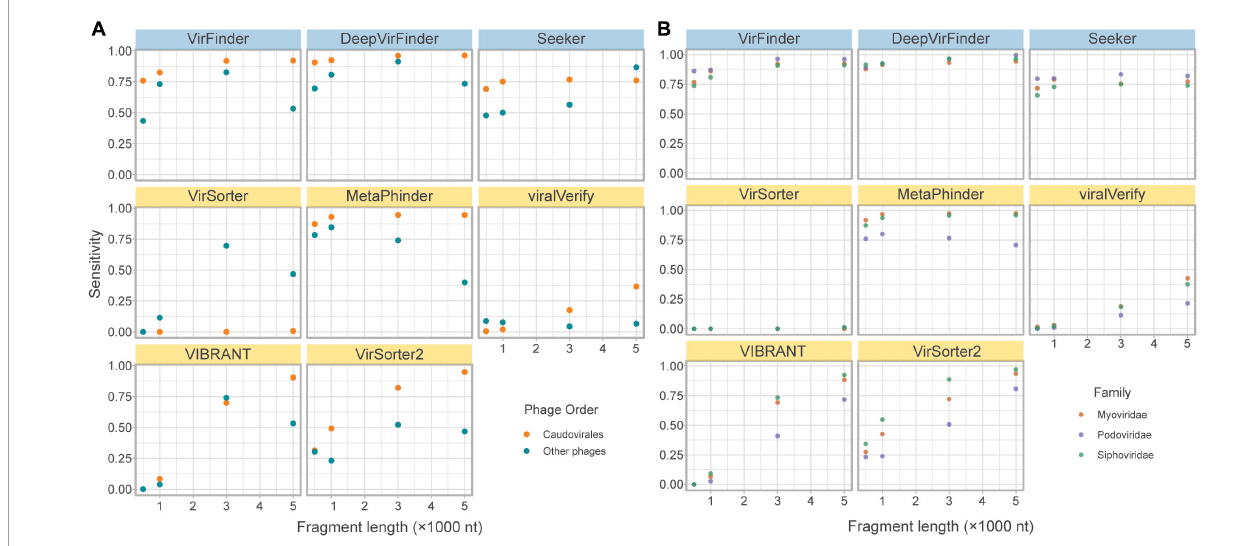
FIGURE4 Effects of phage taxonomy on sensitivity. (A) Sensitivity plotted against fragment length, comparing bacteriophages in the order Caudovirales and those in other orders. (B) Sensitivity plotted against fragment length, comparing bacteriophages in the top three families of the order Caudovirales. Top row of tools are sequence-based (in blue), bottom two rows are homology-based (in yellow).